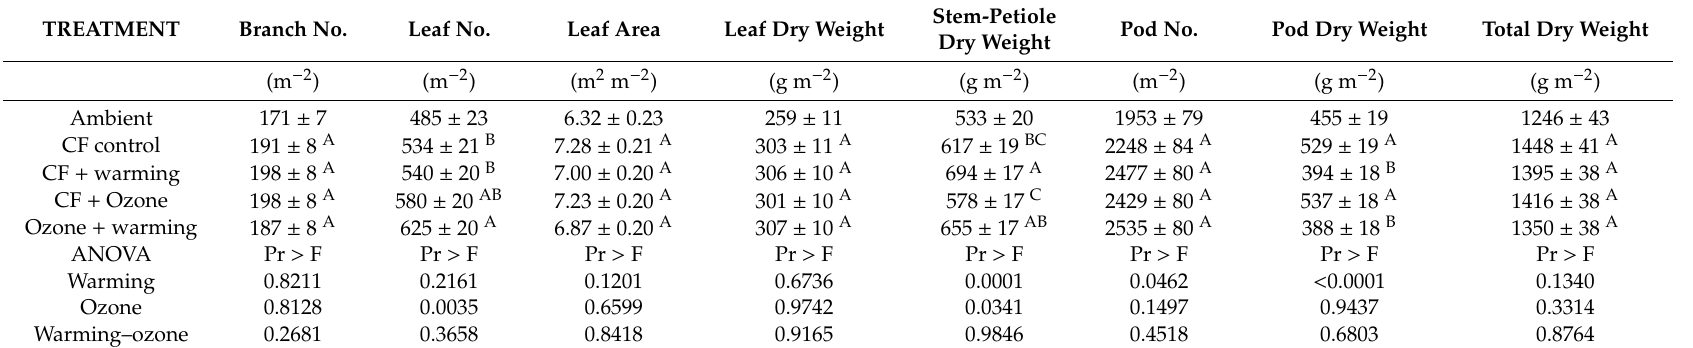
Table 3. Mid-season soybean biomass at the pod filling stage.